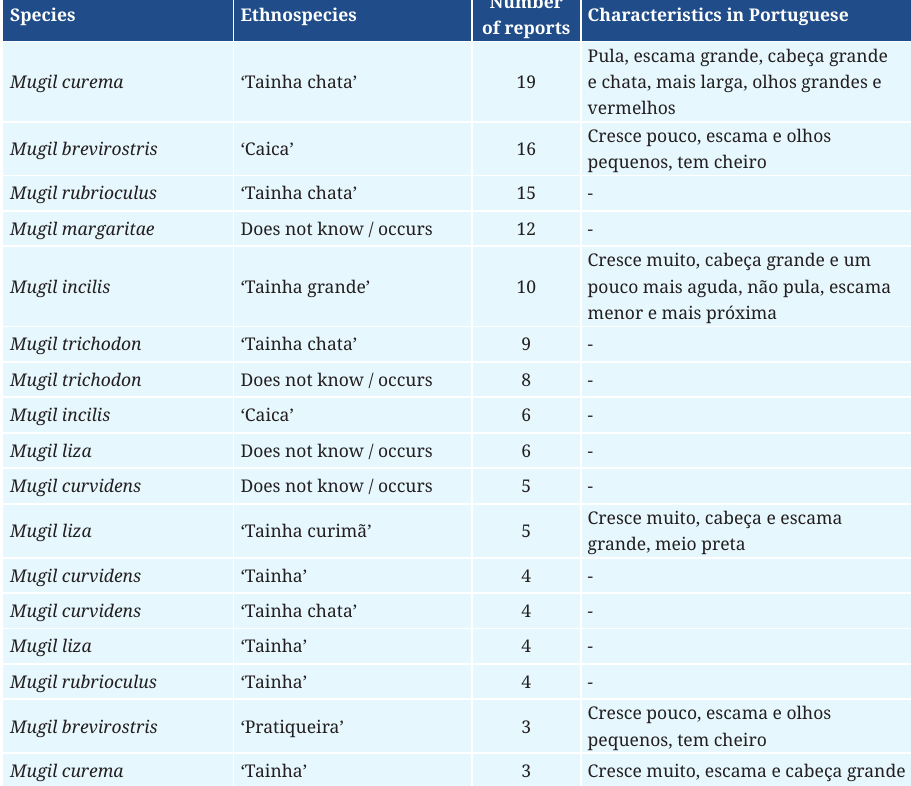
TABLE 2 | Scientific species of Mugil genus with their respective vernacular names and number of reports by the fishers of the Caeté-Taperaçu Marine Extractive Reserve in Bragança, northern Brazil. Catalog of photographs of mugilid species to view of photographs of mugilid species used (see S2 ).